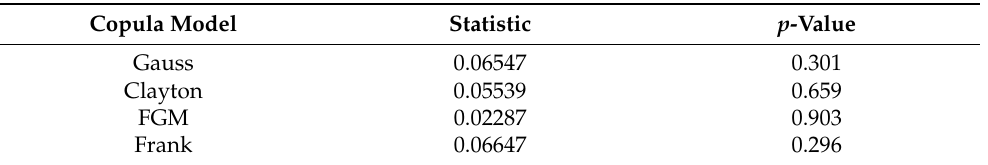
Table 3. Results of goodness-of-fit tests for the copula model based on p -value and statistic on the (0,1)